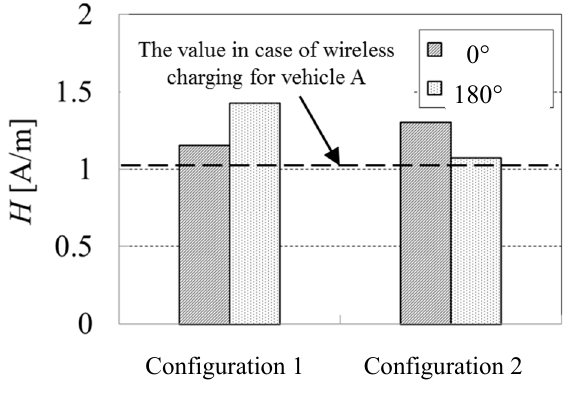
Figure 5. Average magnetic field strength.